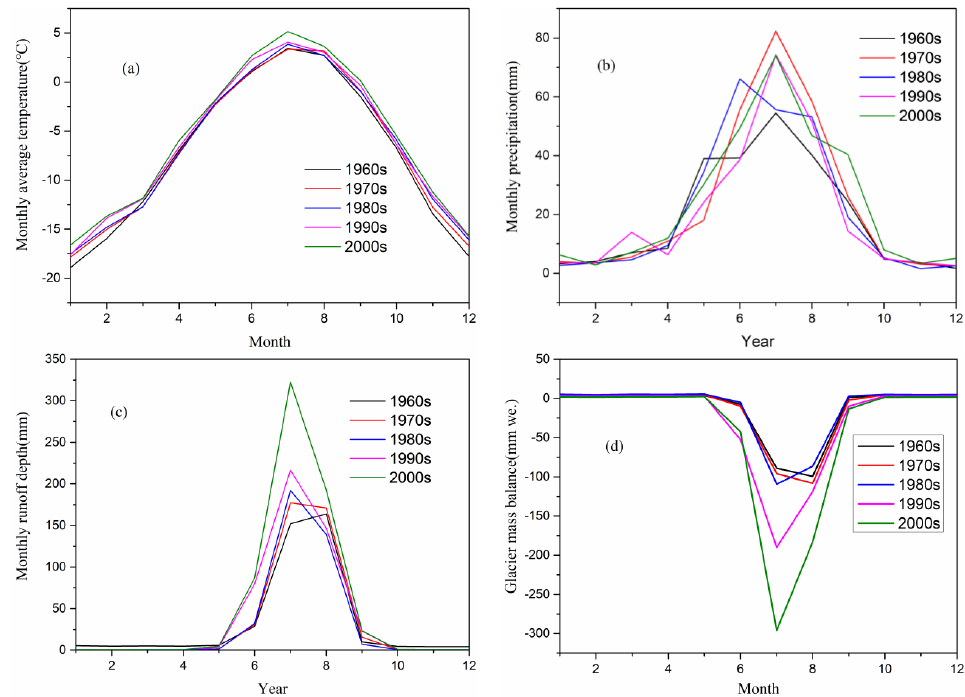
Figure 11. Monthly average air temperature ( a ), monthly decade average precipitation ( b ), runoff depth ( c ), and glacier mass balance ( d ) in different decade.